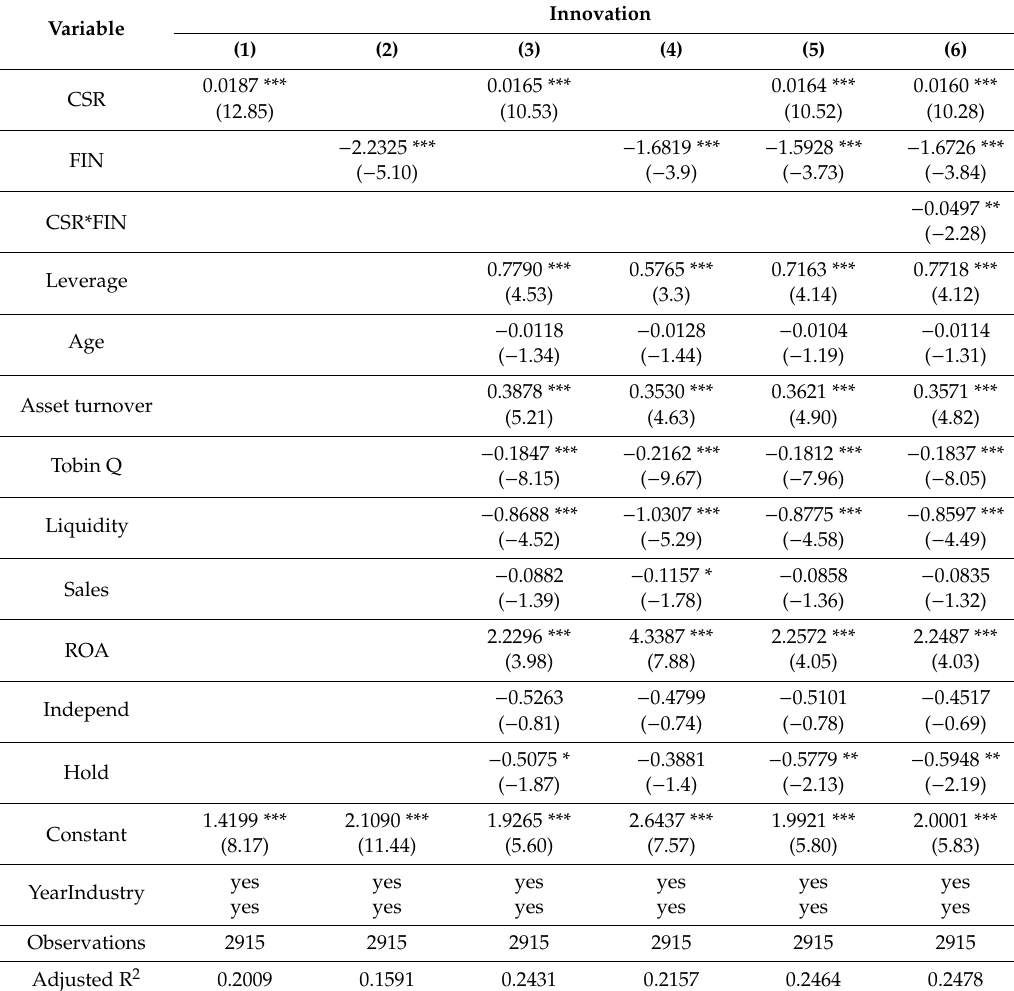
Table 4. Baseline results of overall